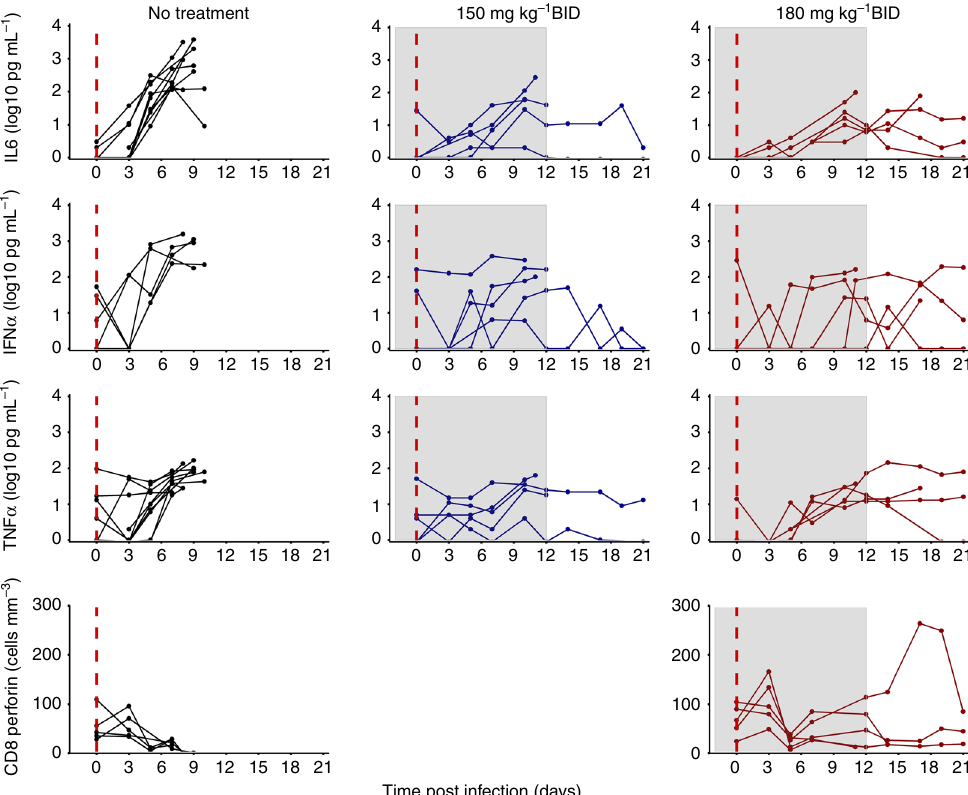
Fig. 2 Cytokine and immunological data. Plasma pro in fl ammatory cytokines Interleukin-6, Interferon α and Tumor necrosis factor α , and CD8 T cells expressing perforin in macaques left untreated (black, left panels), receiving favipiravir 150 mg kg − 1 BID (blue, middle panels) or 180 mg kg − 1 (red, right panels). Gray areas correspond to dosing